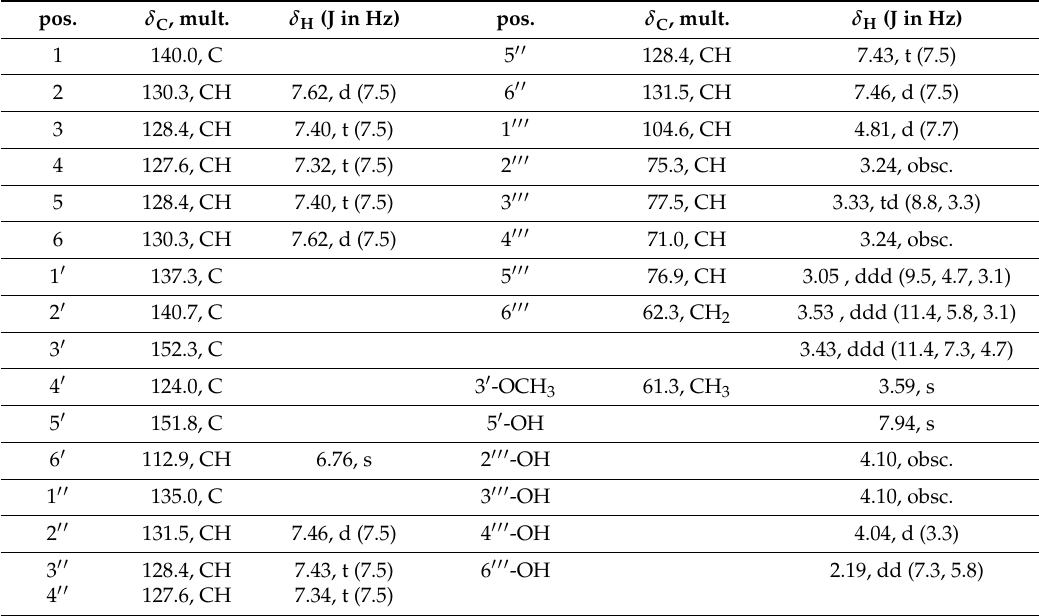
Table 2. 1 H- and 13 C-NMR data (600 and 150 MHz, respectively) for compound 4 at 30 ◦ C in acetone- d 6 . pos.